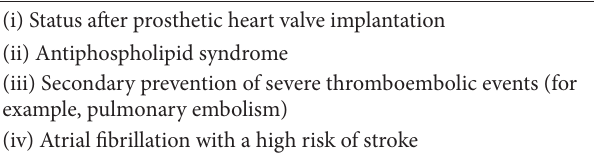
Table 4: Potential indications for oral anticoagulants in patients with end-stage renal disease and receiving